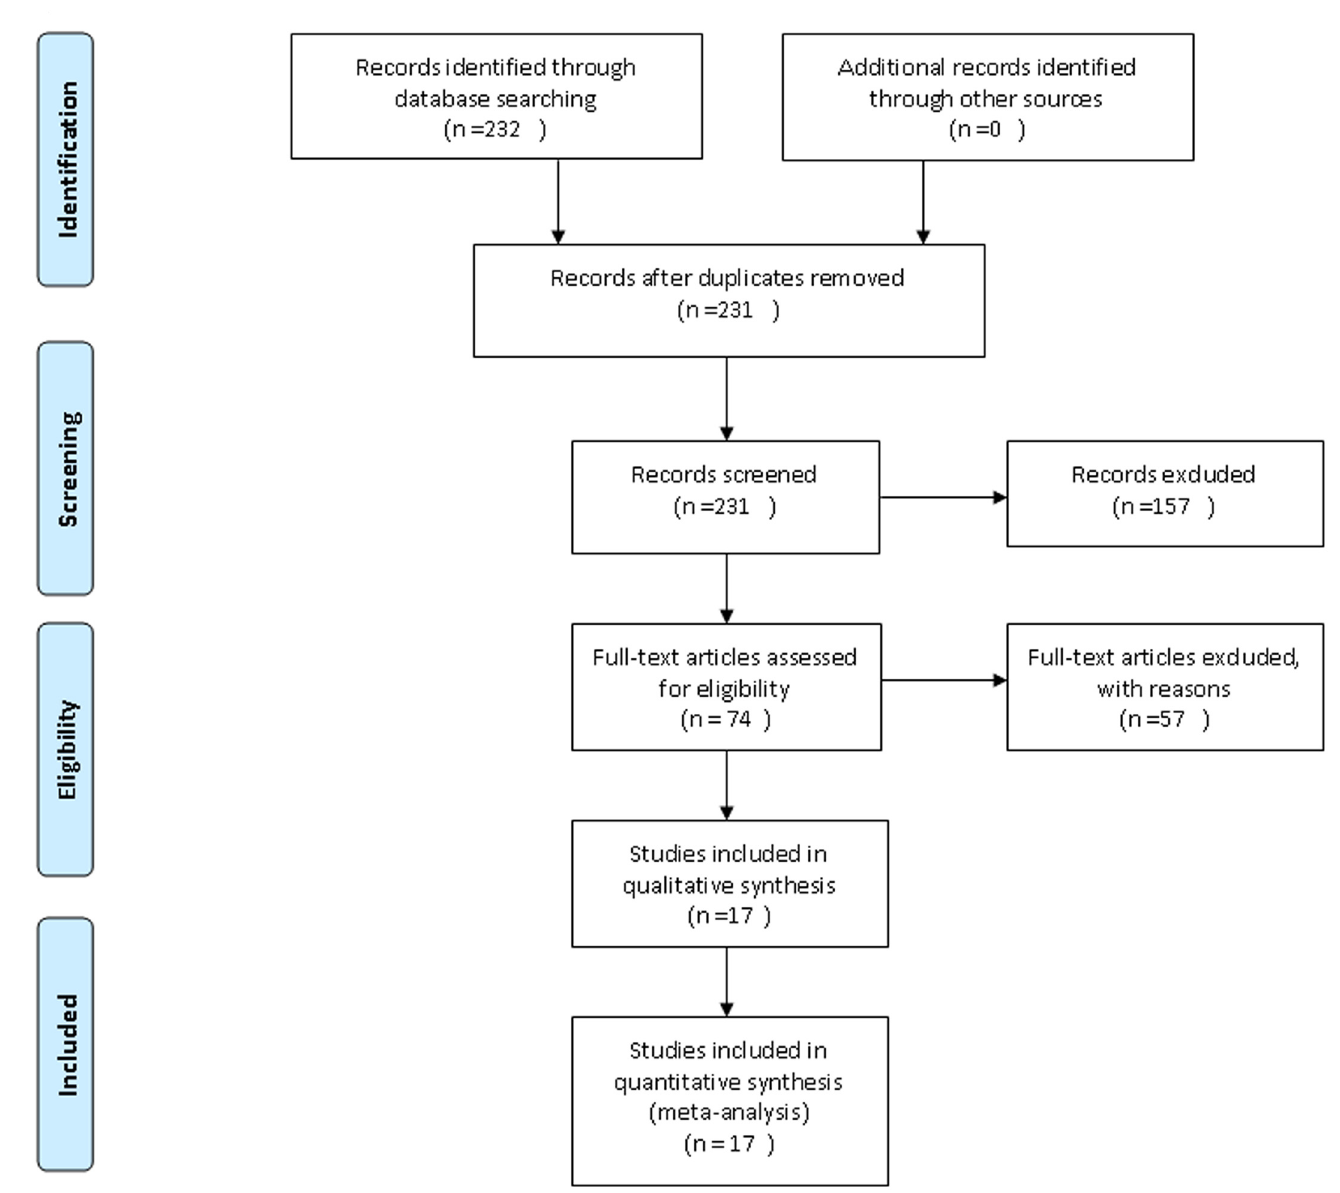
Fig 1. Flow diagram of the network